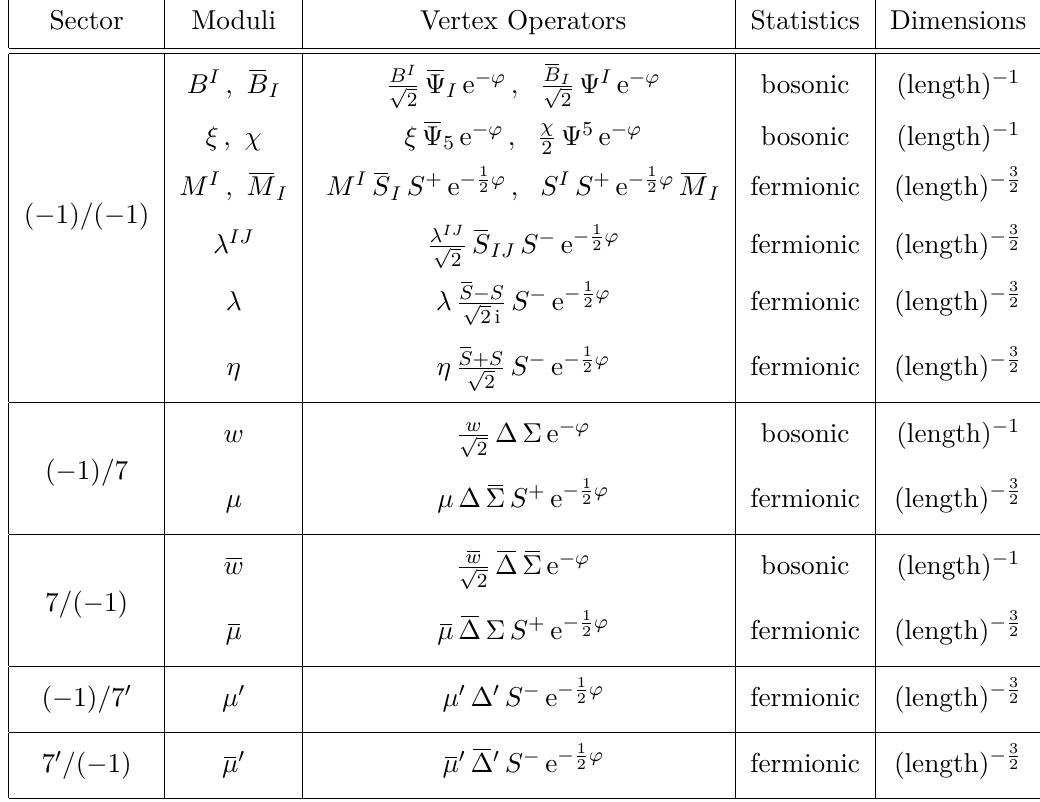
R sector and Σ( z ) in the NS sector. Both Σ( z ) and Σ( z ) are conformal fields of weight 1